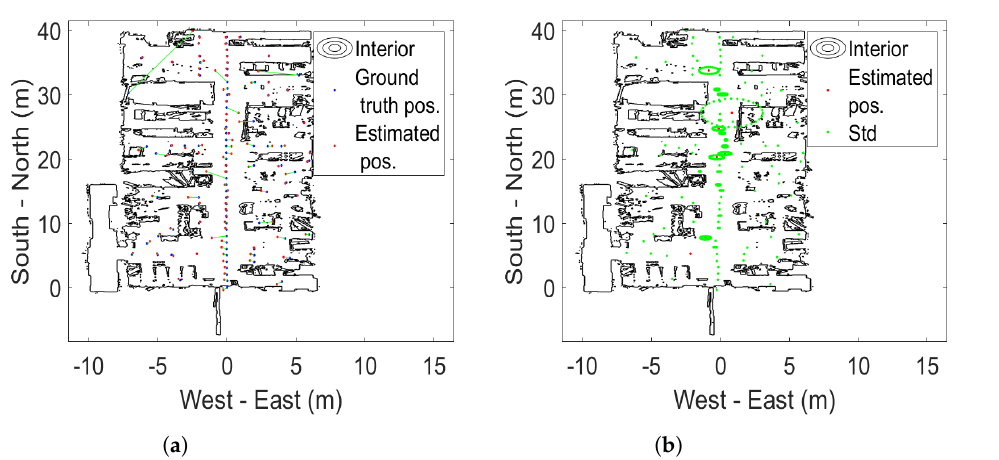
Figure 4. Static case results for GoT at 1 m altitude. ( a ) Estimated positions from GoT (red) vs ground- truth (blue) with connecting line (green). ( b ) Estimated positions from GoT (red) and standard deviation ellipsoids (green).